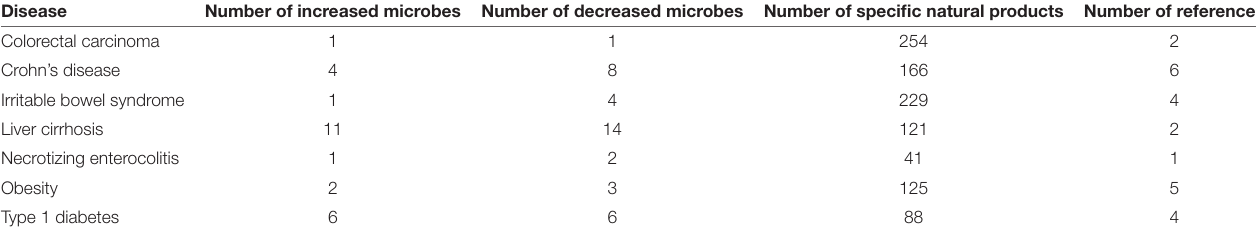
TABLE 1 | The general information on diseases, microbes, and natural products.